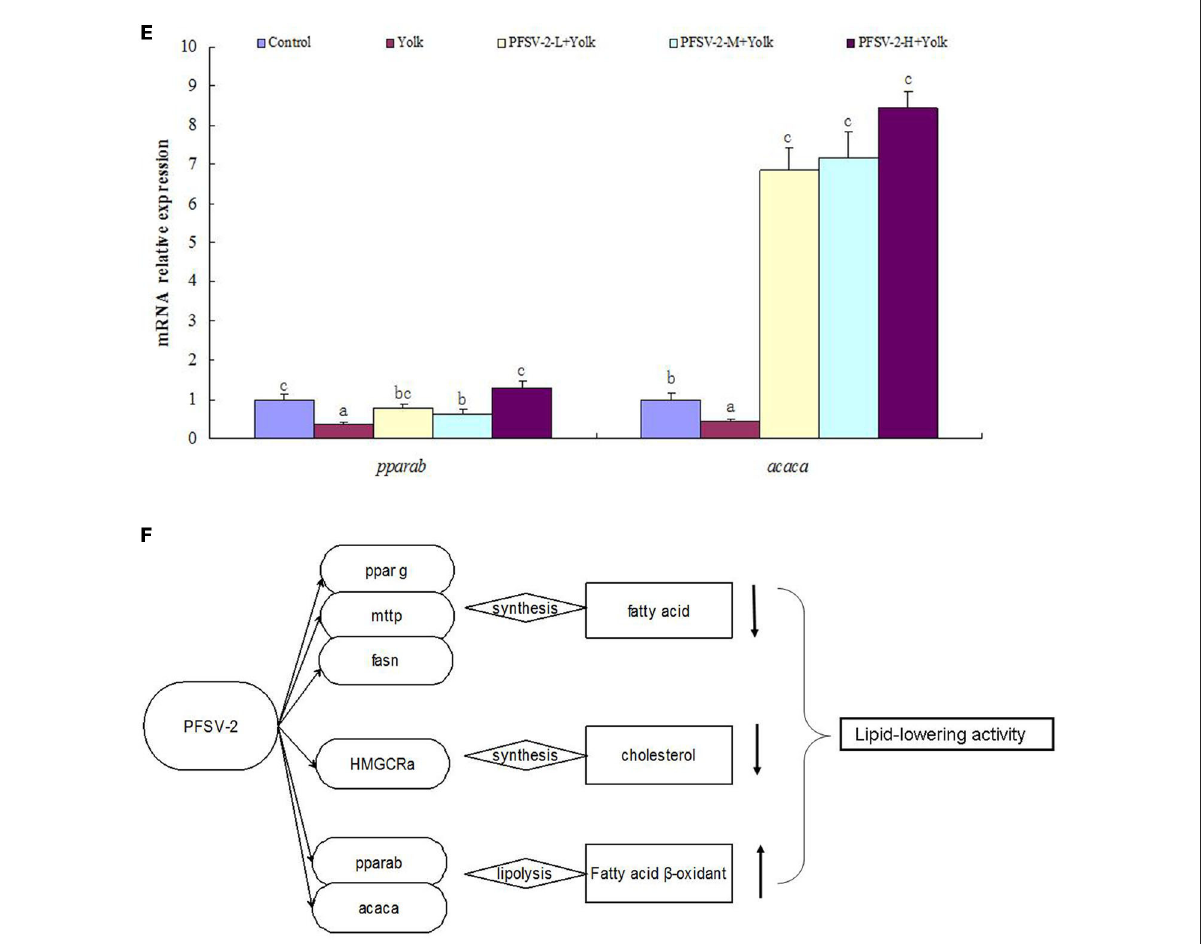
FIGURE4 Total cholesterol [TC, (A) ] and triglyceride [TG, (B) ] levels of larval zebrafish in each group ( n = 3); mRNA expression of pparg, fasn, and mtp on zebrafish larvae (C) ; mRNA expression of pparab and acaca on zebrafish larvae (D) , mRNA expression of HMGCRa and HMGCRb on zebrafish larvae (E) , and molecular mechanisms of lipid metabolism modulation by PFSV-2 (F). Bar indicates means ± SD. Bars without the same superscripts (a–e) denote significant difference ( p <